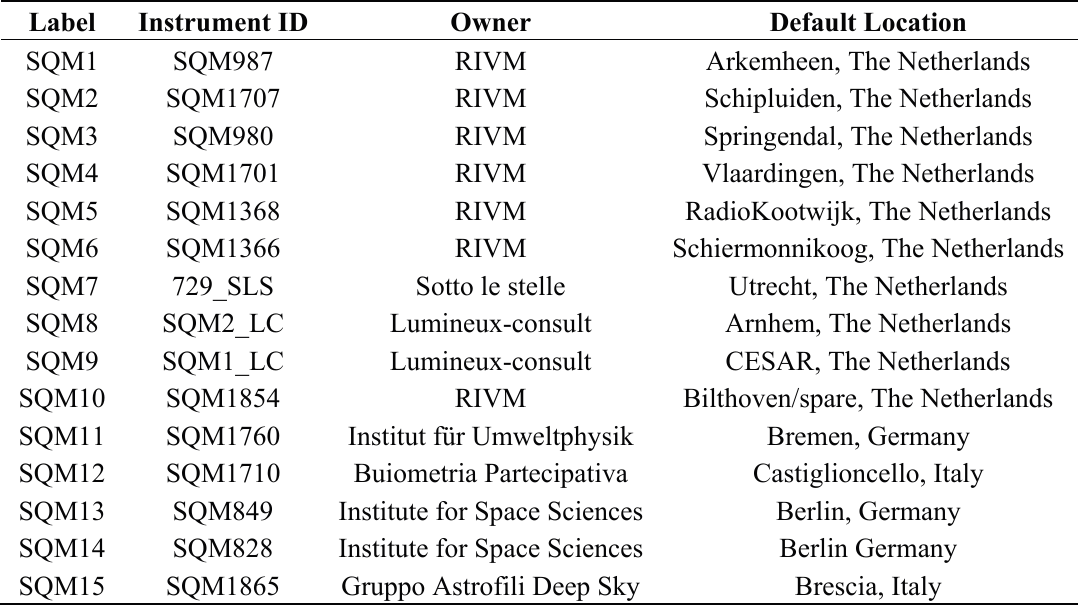
Table 1. Key to SQM